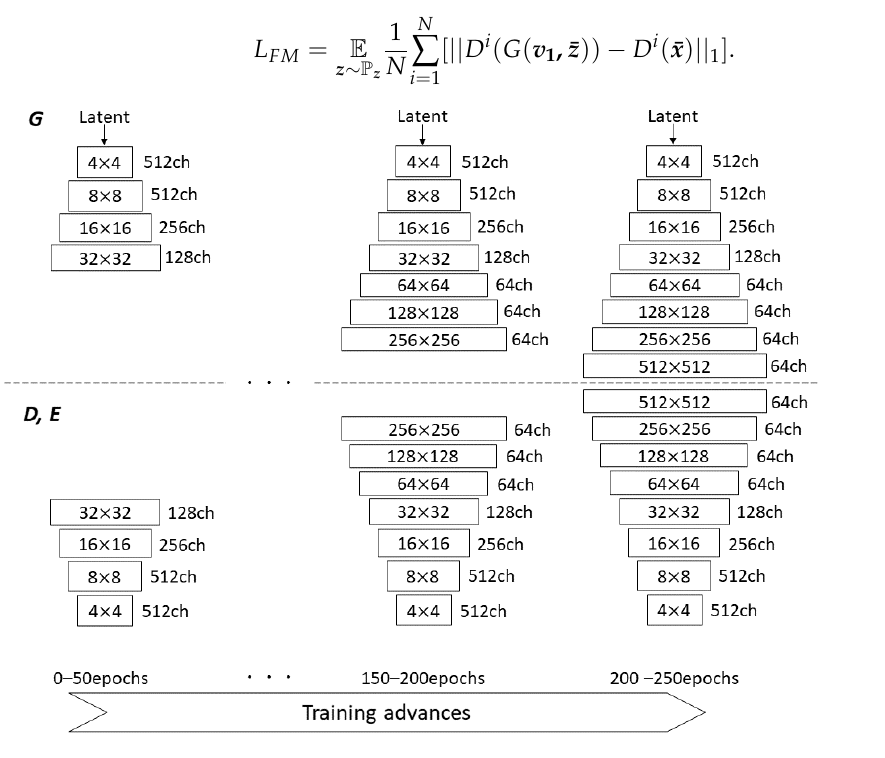
Figure 2. Gradually increasing image resolution in the generator, discriminator, and encoder as training advances through the progressive growing technique.